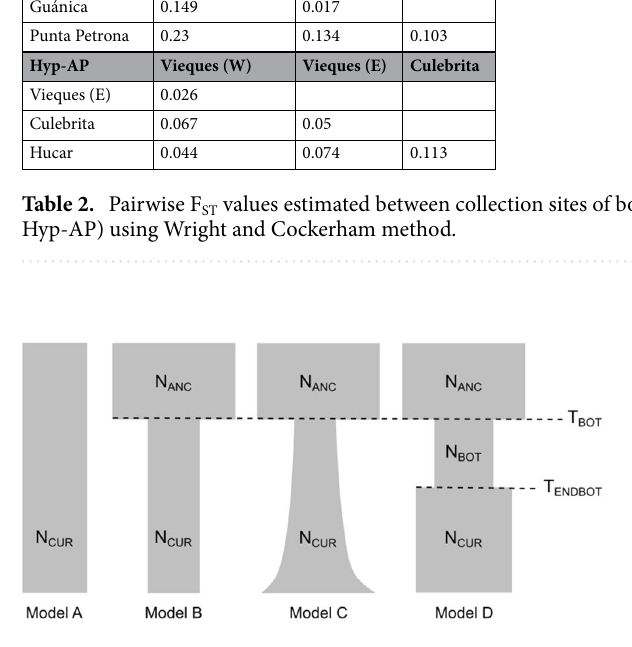
Figure 4. Schematic representation of demographic models. Estimated parameters of demographic models using Fastsimcoal2 included timing of bottleneck (T BOT and T ENDBOT ), historical effective population sizes (N ANC , N BOT ) and exponential growth rate (G R ). Contemporary effective population size (N CUR ) was fixed in the models.